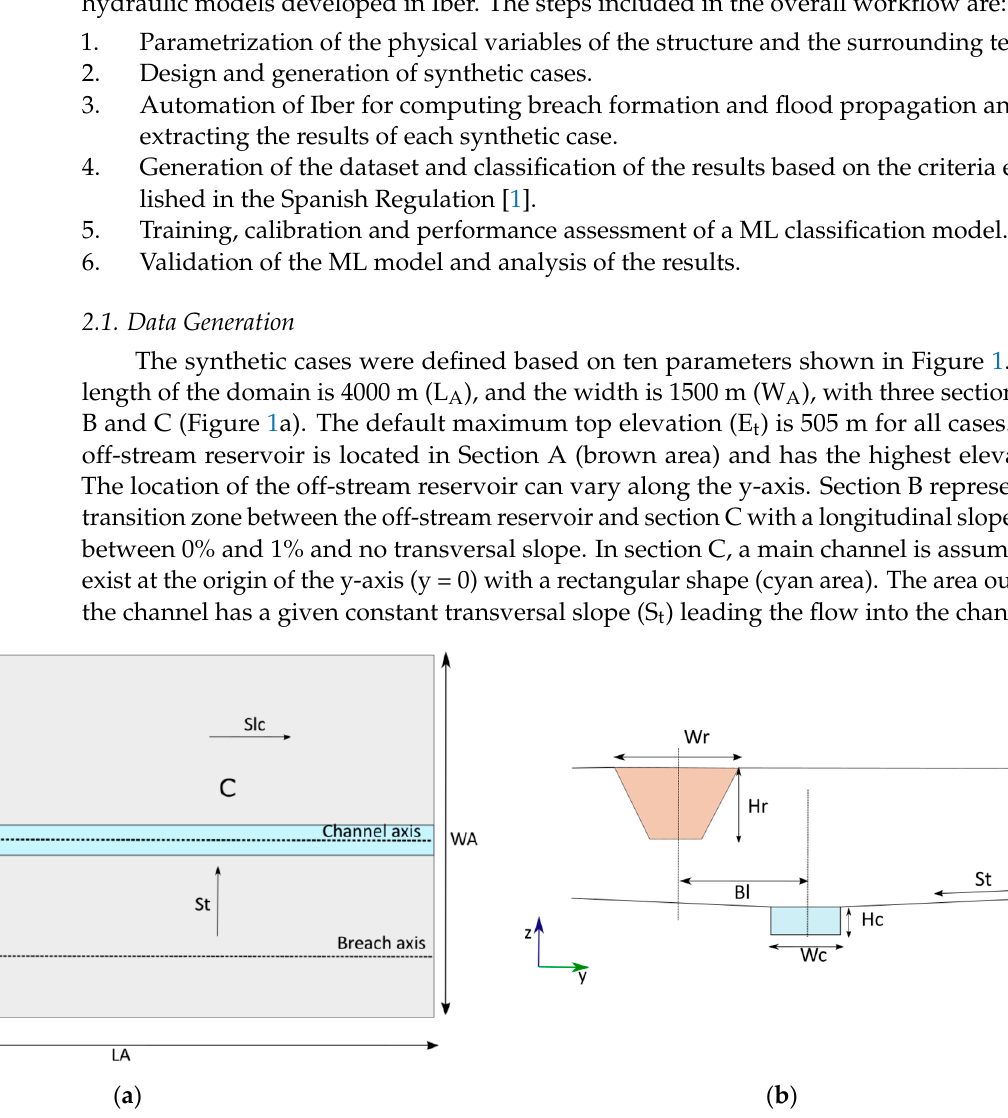
Table 1. Geometry parameters and ranges of variation. Parameter Symbol Unit. Min.